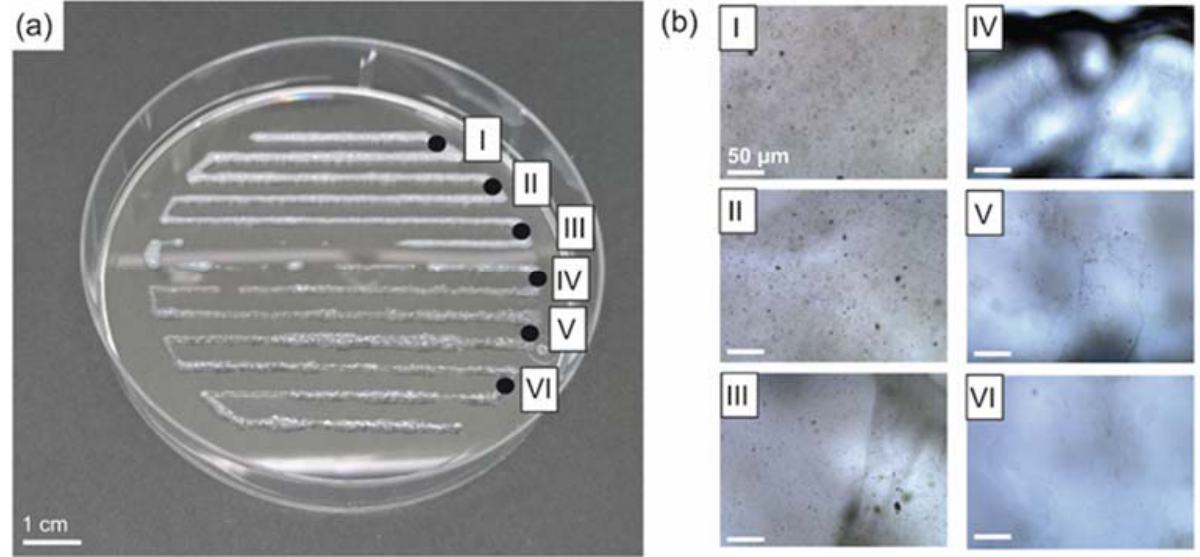
Figure 4. Three-dimensional printed gradient of recombinant spider silk hydrogels (3% w / v ) with and without fluorapatite particles. (FAp) ( a ) Gradient from 3% w / v eADF4(C16) + 1% w / v κ FAp (white) to 3% w / v eADF4(C16) (transparent). Numbers I-VI indicate the positions for enlarged images in ( b ). ( b ) Light microscopy images at distinct locations of the construct showing decreasing particle concentration (highest at position I and lowest at position VI), scale bar 50 µ m. κ FAp refers to FAp particles coated with eADF4( κ